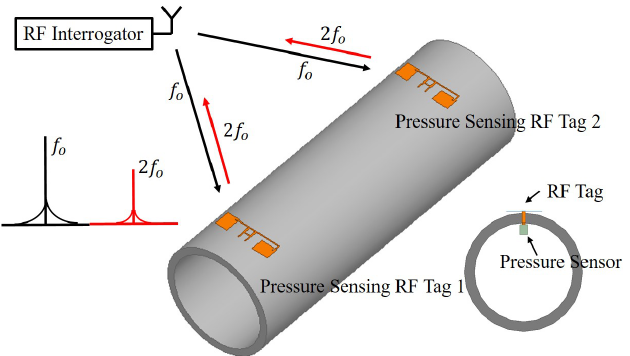
Figure 1. Proposed passive wireless sensing system for the pipeline